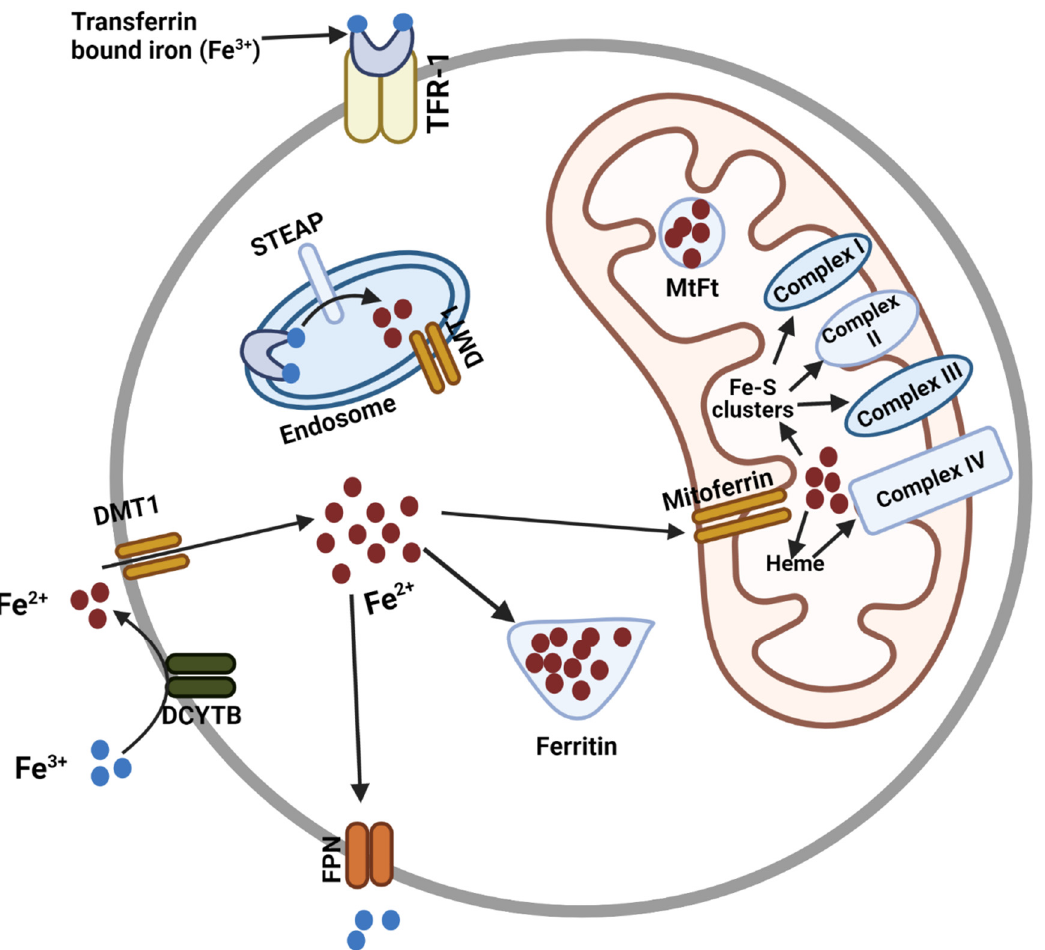
Figure 1. Overview of cellular and mitochondrial iron homeostasis. Tf-bound iron (Fe 3+ ) is internal- ized into cytosol through TFR-1. Fe 3+ is then converted to Fe 2+ by STEAP in endosomes. Endosomal Fe 2+ is then released into the cytosol thorough DMT1. A small portion of iron that is not bound to Tf can be converted to Fe 2+ by duodenal cytochrome B (DCYTB) and incorporated into cytosol by DMT1. These cytosolic Fe 2+ can then be stored in ferritin, exported out of the cell by ferroportin (FPN), or transported to the mitochondria by mitoferrin. In the mitochondria, iron is used for the generation of iron-sulfur clusters or heme synthesis. The iron sulfur (Fe-S) clusters and heme are used in different proteins and enzymes in the mitochondria. Fe-S clusters and heme can be exported to the cytosol for other cellular utilization. Iron can be stored in mitochondrial ferritin (MtFt) as well. Created with BioRender (Science Suite Inc., Toronto, ON, Canada).